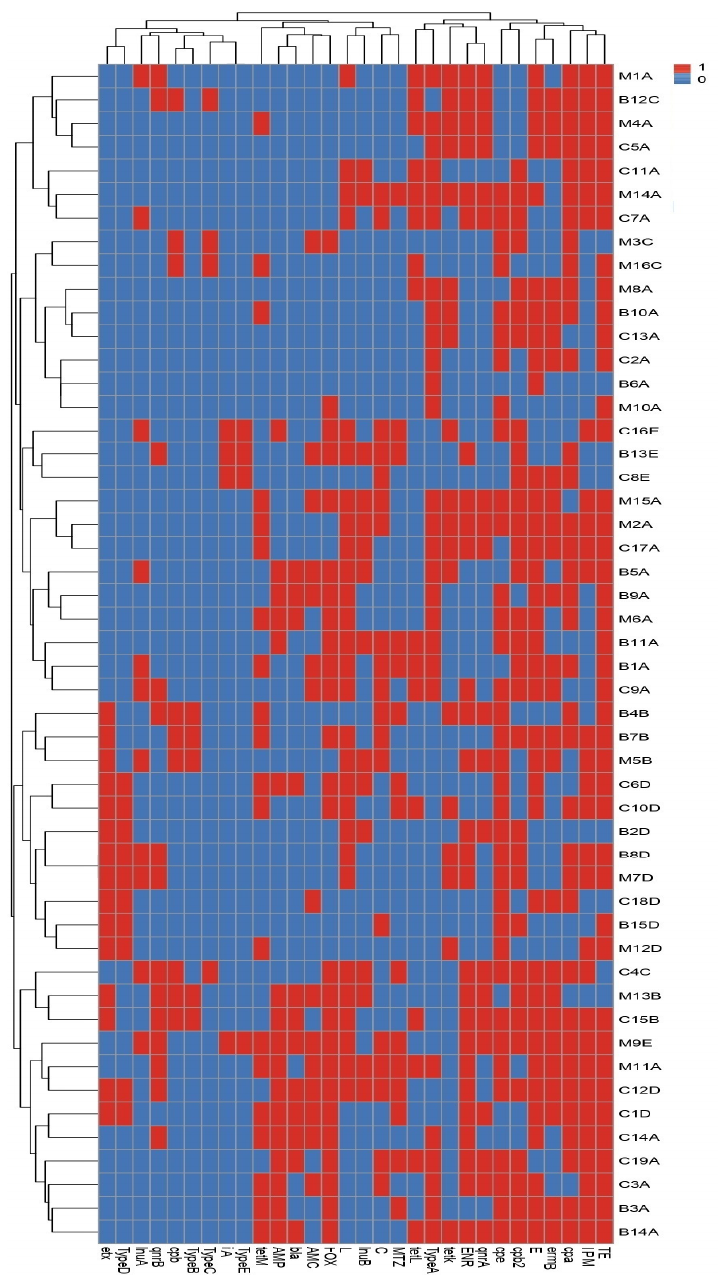
Figure 2. Heat map and hierarchical clustering of the examined C. perfringens isolates based on the occurrence of antimicrobial resistance, antibiotic resistance, and toxin genes and toxinotypes. In the heat map, red and blue colors refer to the resistance/sensitivity to an antimicrobial agent and to the presence/absence of an antibiotic resistance, the toxin gene and toxinotype, respectively. The code numbers on the right of the heat map refer to the isolate numbers for beef (B), chicken meat (C), and milk (M) samples. AMP, ampicillin; AMC, amoxicillin/clavulanic acid; FOX, cefoxitin; ENR, enrofloxacin; IPM, imipenem; C, chloramphenicol; L, lincomycin; MTZ, metronidazole; E, erythromycin; TE, tetracycline. The tet(K) , tet(L) , and tet(M) ; lnu(A) and lnu(B) ; erm(B) ; bla ; and qnrA and qnrB are genes associated with tetracycline, lincomycin, erythromycin, β-lactams, and enrofloxacin resistances, respectively. The cpa, cpb, etx, ia, and cpe are C. perfringens alpha, beta, epsilon, iota, and enterotoxin genes , respectively, and cpb2 is the C. perfringens beta2 toxin gene.